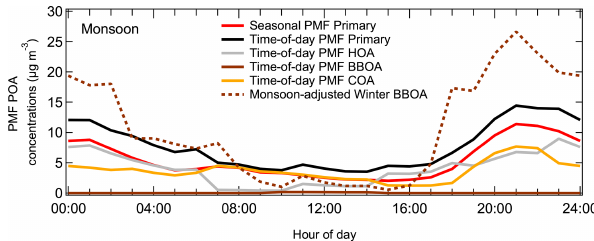
Figure 2. Diurnal patterns of seasonally representative hourly av- eraged primary PMF factors in the 2017 monsoon season. Traffic and cooking contribute almost equally, whereas biomass burning has negligible